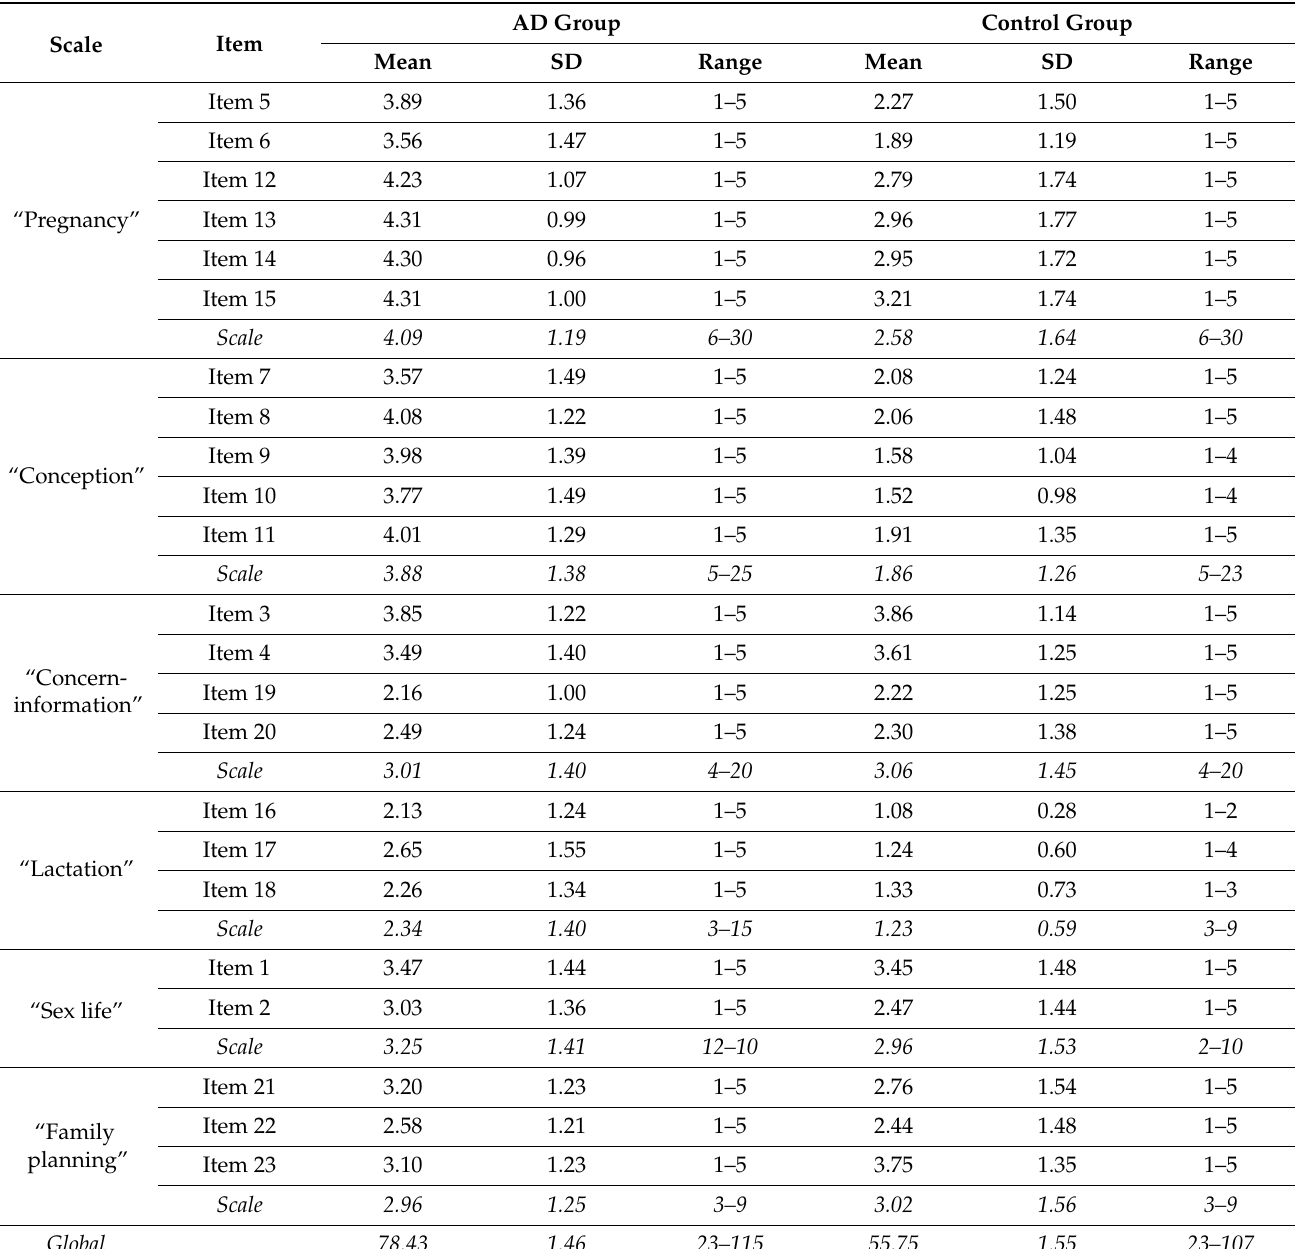
Table 4. Scores obtained in the